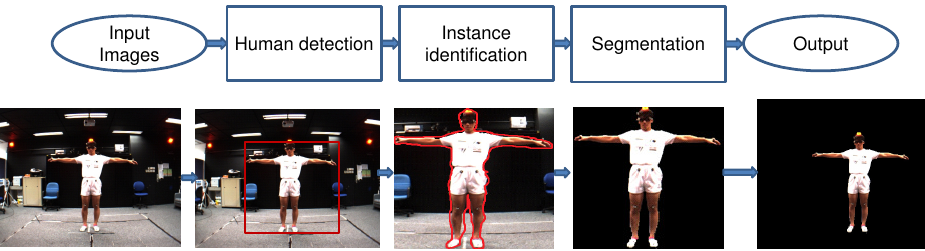
Figure 3. Illustration of the model of human segmentation in